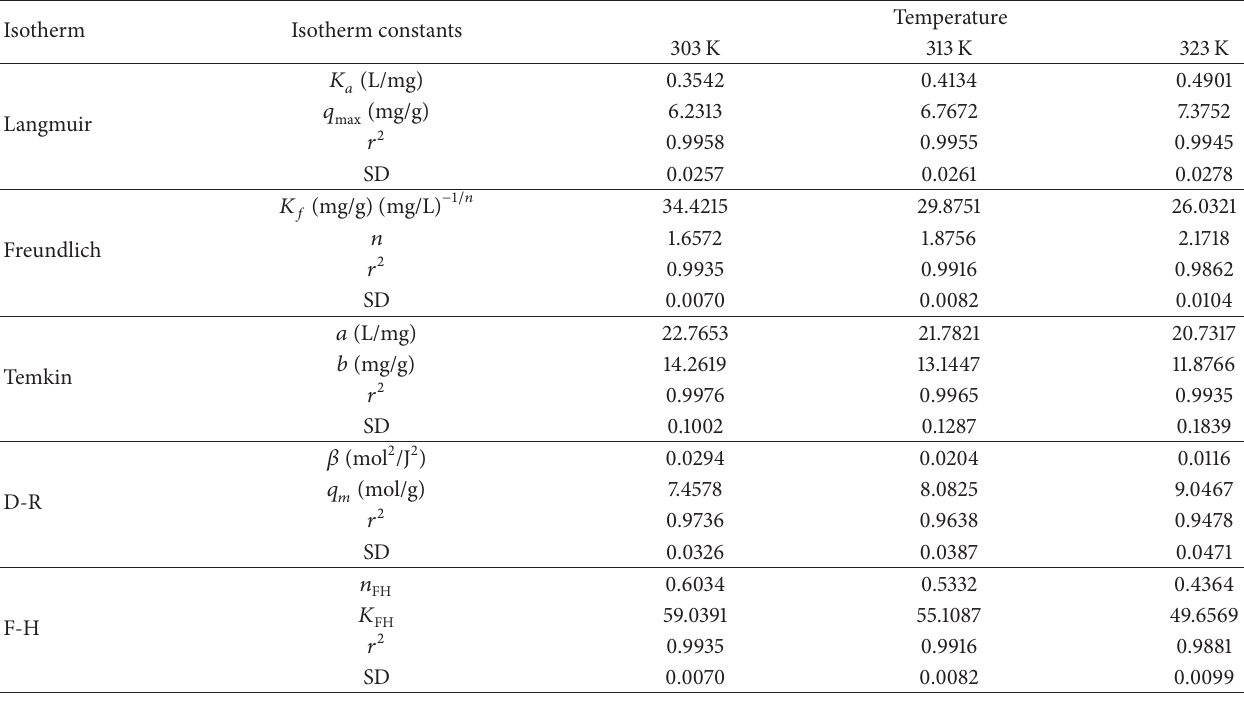
Table 2: Equilibrium constants of various isotherm models for the adsorption of arsenic on activated Moringa oleifera . Isotherm